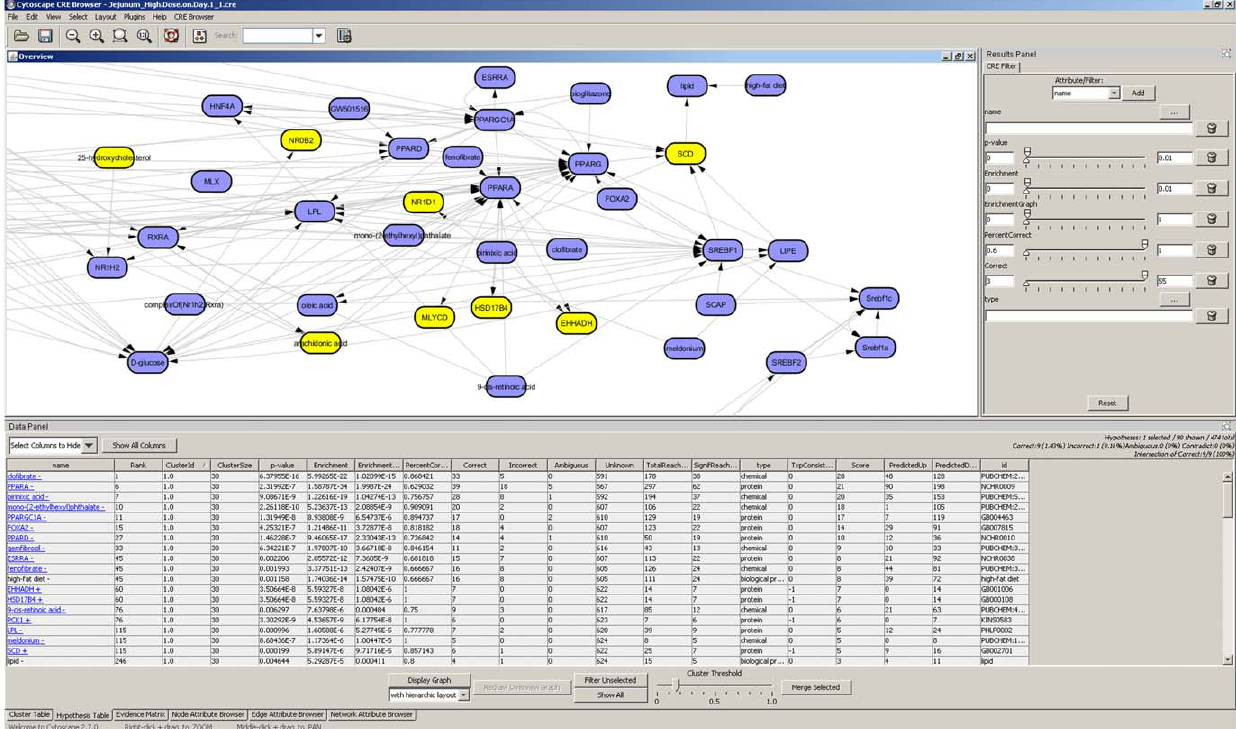
Figure 1. A screen shot of the cytoscape based causal reasoning engine browser showing the network overview window, hypothesis table and parameters filter panel.